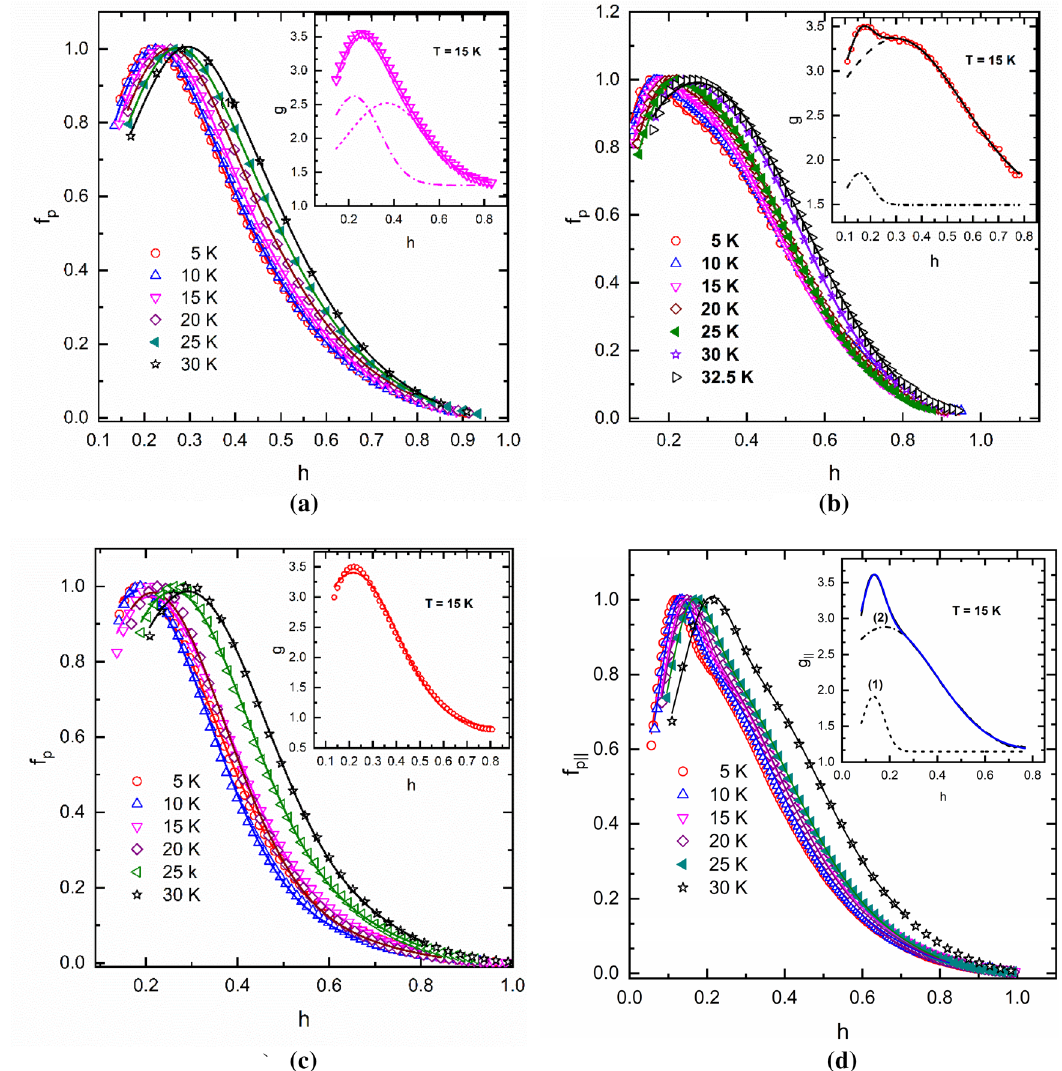
Figure 3. The dependence of the reduced pinning force f p on the reduced magnetic field and the fits with Eq. (2) (continuous lines) in the temperature range 5–30 K: ( a ) pure MgB 2 (sample ( i )); ( b ) (MgB 2 ) 0.99 (TeO 0.25 (HoO 1.5 ) 0.75 ) 0.01 (sample ( ii )); ( c ) (MgB 2 ) 0.99 (B 4 C) 0.01 (sample ( iii )); ( d ) partially textured MgB 2 (sample ( iv )). Insets show the h -dependence of the function g at T = 15 K. Continuous line is the fit with the distribution function. Dash and dash dotted lines are the decomposition of the double peaked